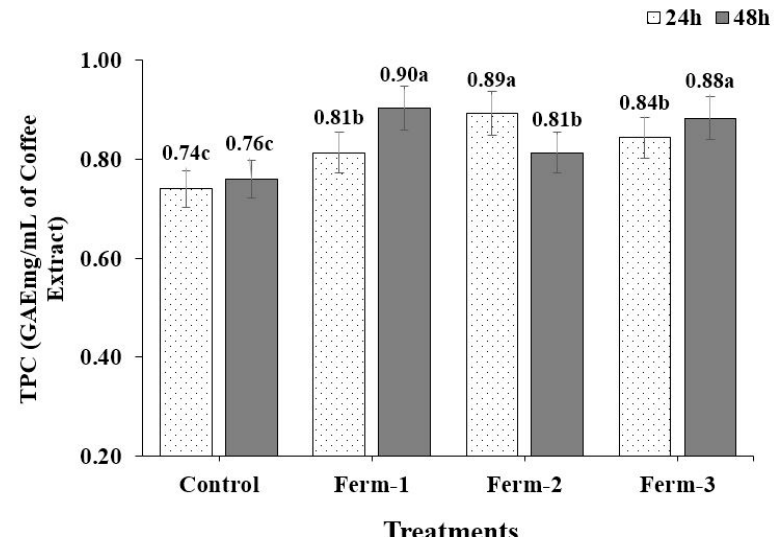
Figure 7. Total polyphenol contents (GAEmg/mL of coffee extract) of fermented coffee. The bars with different letters indicate a significant difference ( p < 0.5) among treatments.